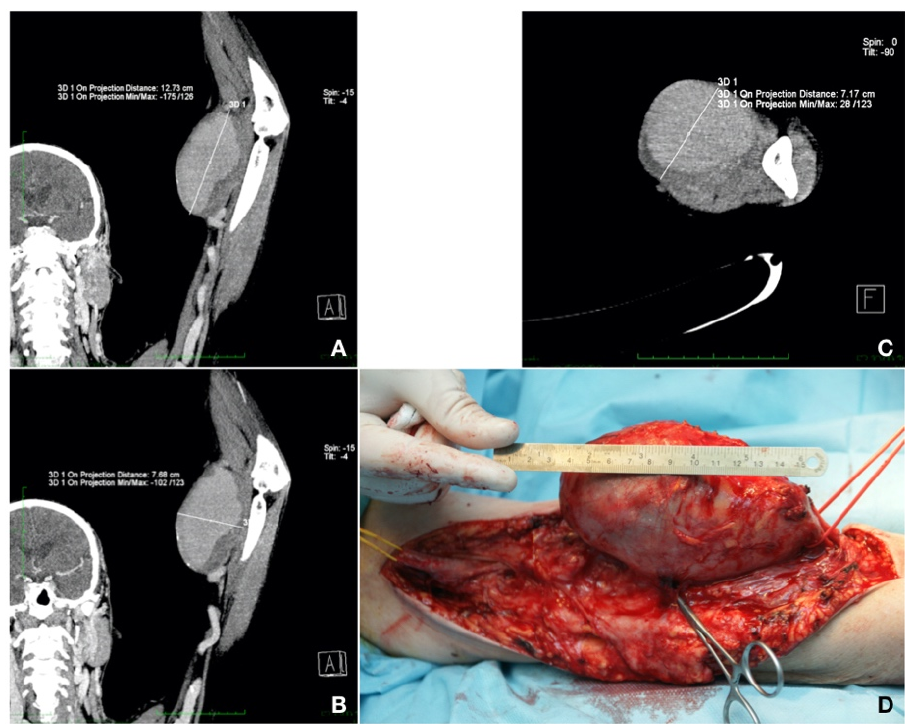
Figure 2. ( A , B ) Longitudinal maximum intensity projection (MIP) section showing the aneurysm. ( C ) Transversal section. ( D ) Intraoperative image showing the dimensions of the aneurysm and proximal (yellow loop) and distal (red loop) ends of the vessels to be anastomosed with an inverted saphenous graft (personal collection).